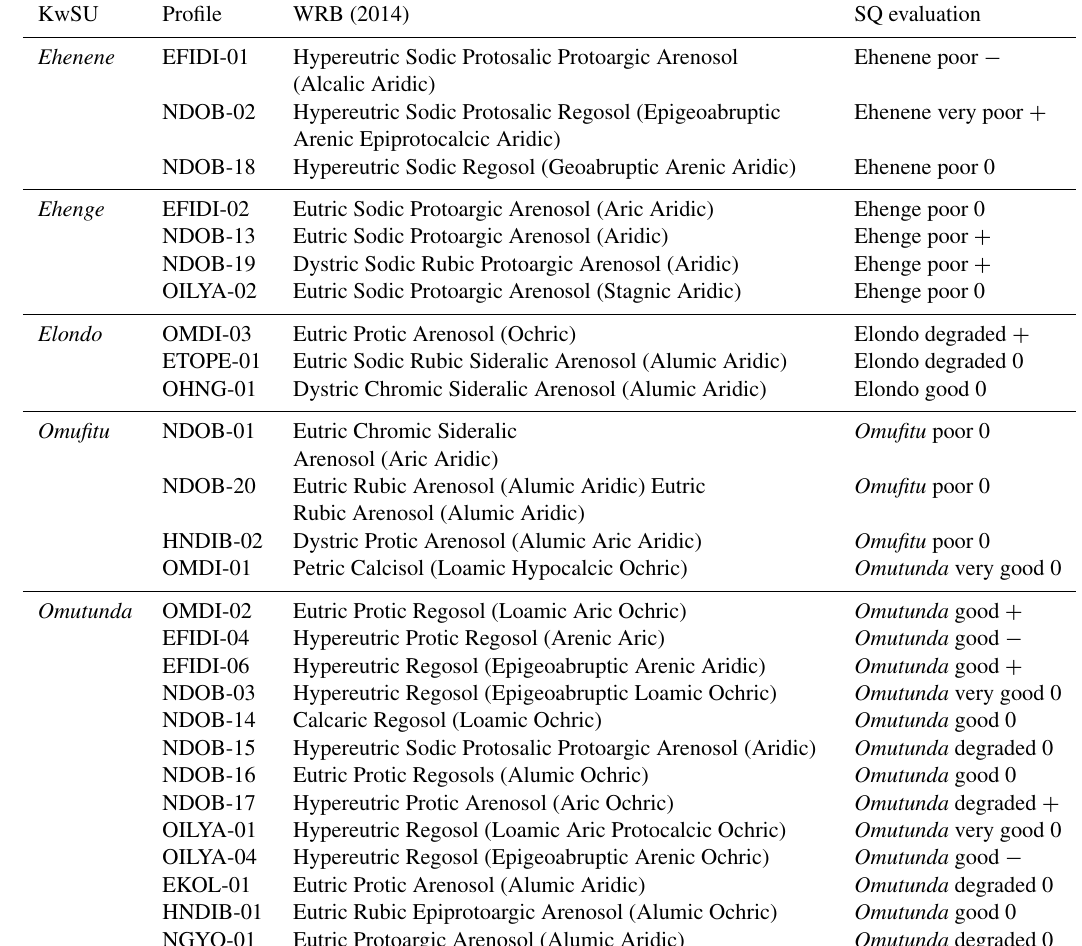
Table 6. Soil classification using World Reference Base for Soil Resources (IUSS Working Group WRB, 2014) and soil quality evaluation using the suggested toolbox.